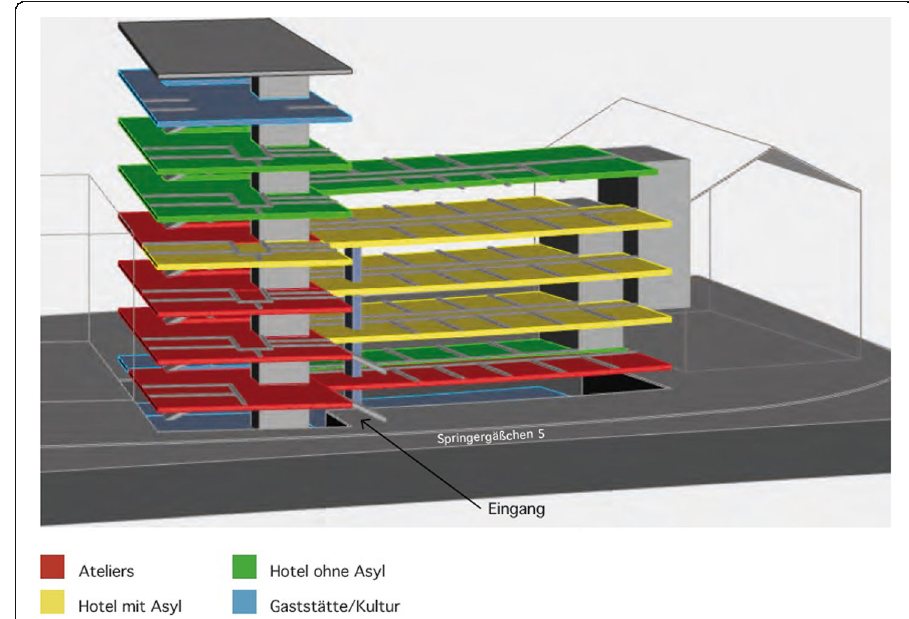
Fig. 2 The internal division of the GHC (red = artists ’ rooms, yellow = ‘ hotel with asylum ’ , green = ‘ hotel without asylum ’ , blue = restaurant and event space (Heber et al., 2011)